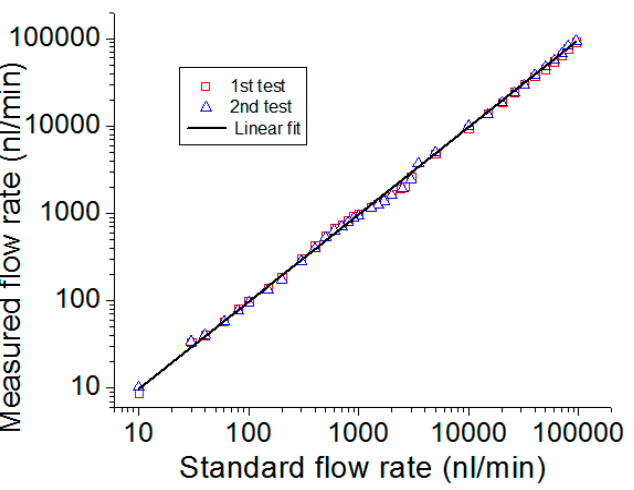
Figure 10. Sensing performance of the dual-mode flowmeter [63].